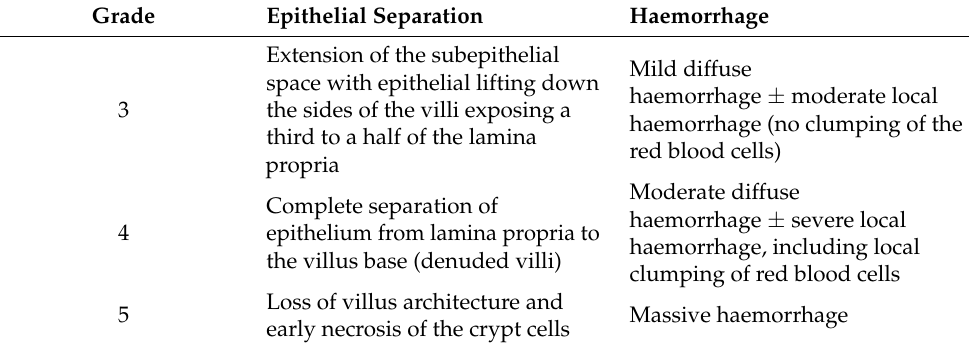
Mild diffuse haemorrhage ± moderate local haemorrhage (no clumping of the red blood cells) Moderate diffuse haemorrhage ± severe local haemorrhage, including local clumping of red blood cells Massive